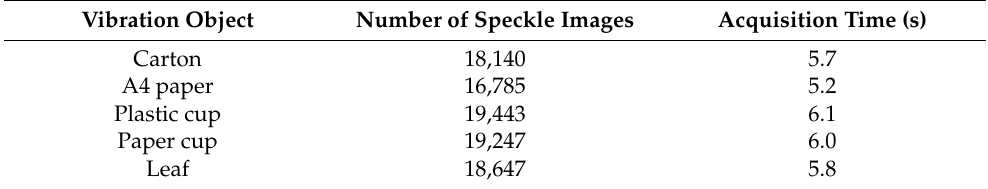
Table 6. The number of speckle images acquisitions for five vibration object